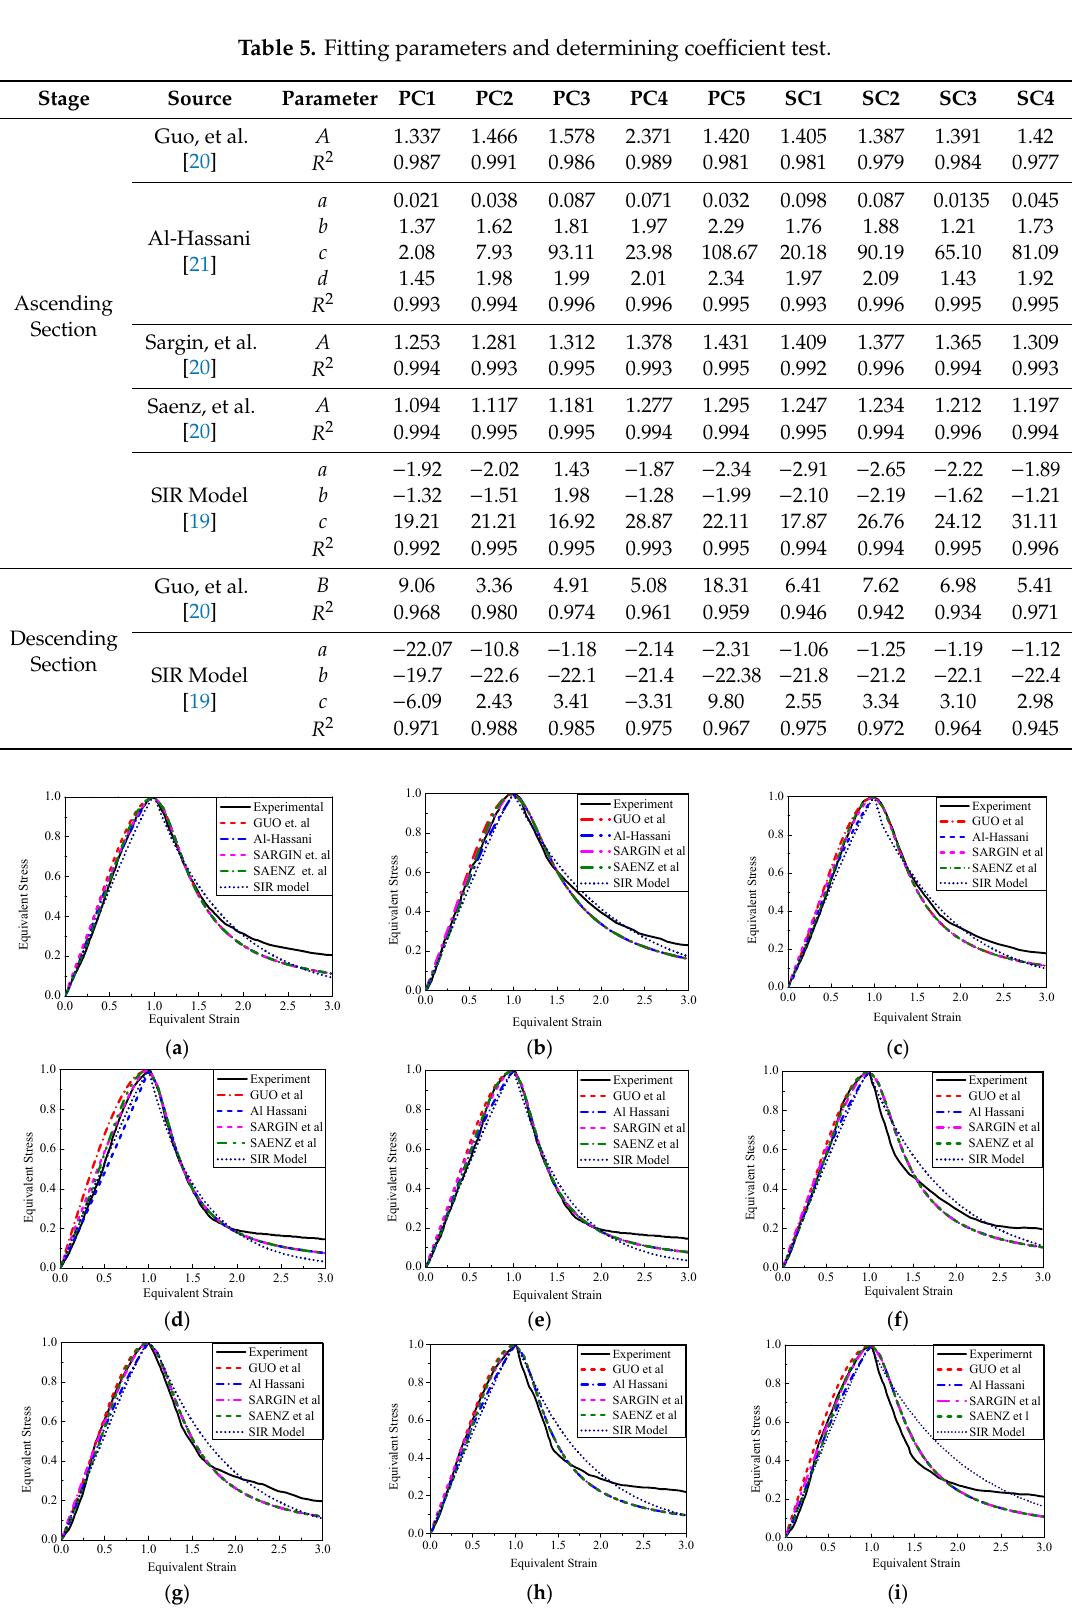
Figure 8. Equivalent strain-stress curve. ( a ) PC1; ( b ) PC2; ( c ) PC3; ( d ) PC4; ( e ) PC5; ( f ) SC1; ( g ) SC2; ( h ) SC3; ( i ) SC4.